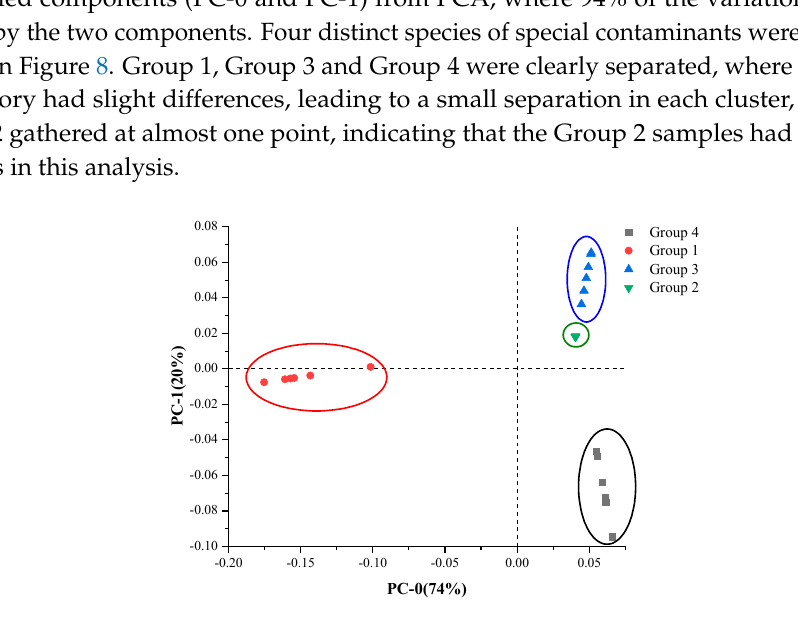
Figure 8. Score plots of PC-0 and PC-1 obtained using PCA.